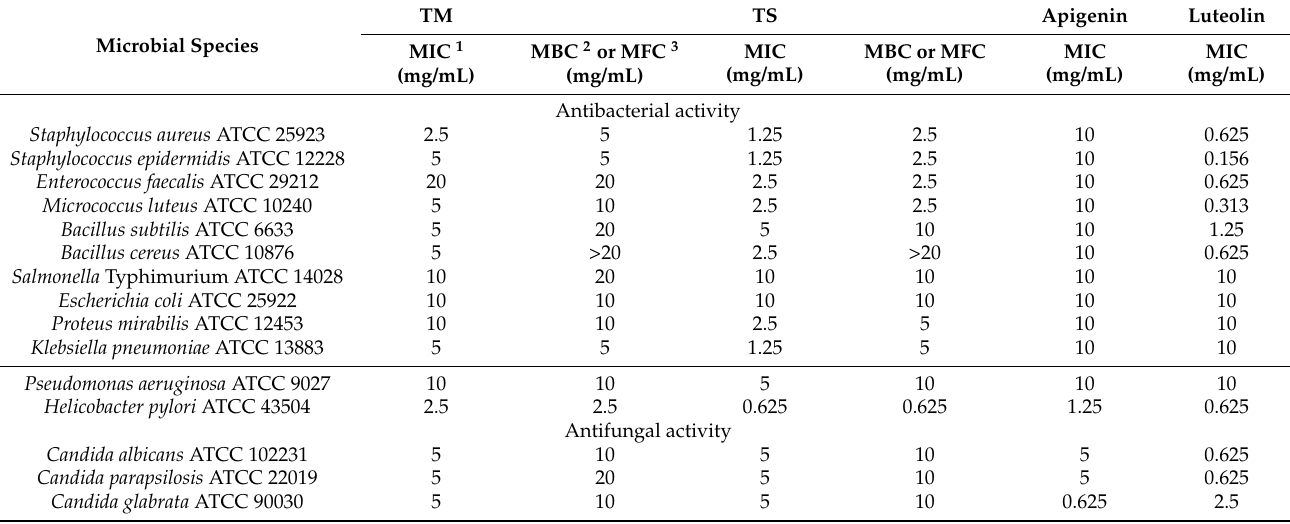
Table 4. Antimicrobial activity in vitro of the hydroethanolic extracts from the aerial parts of Thymus marschallianus (TM) and Thymus seravschanicus (TS).